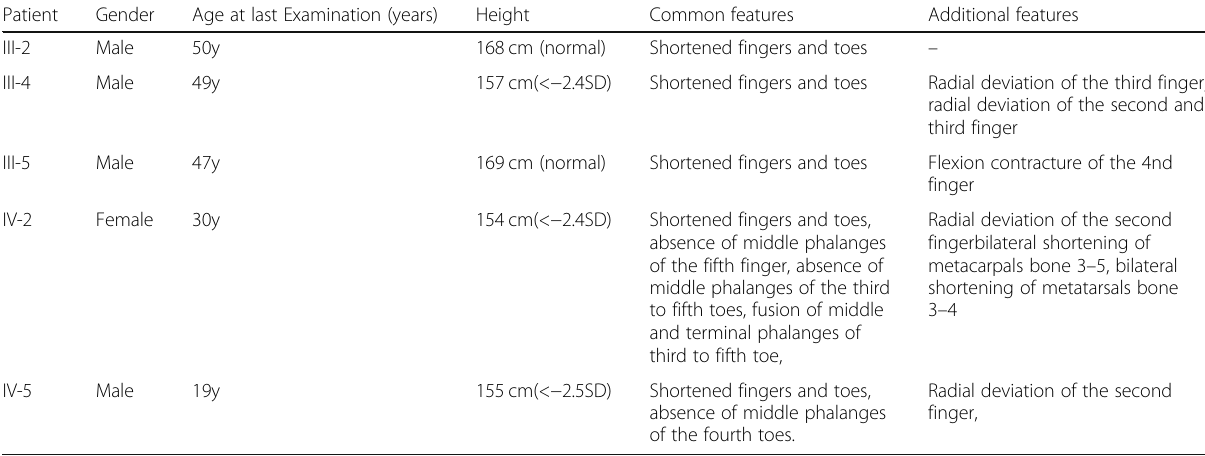
Table 1 Clinical features of the patients with de novo IHH mutations